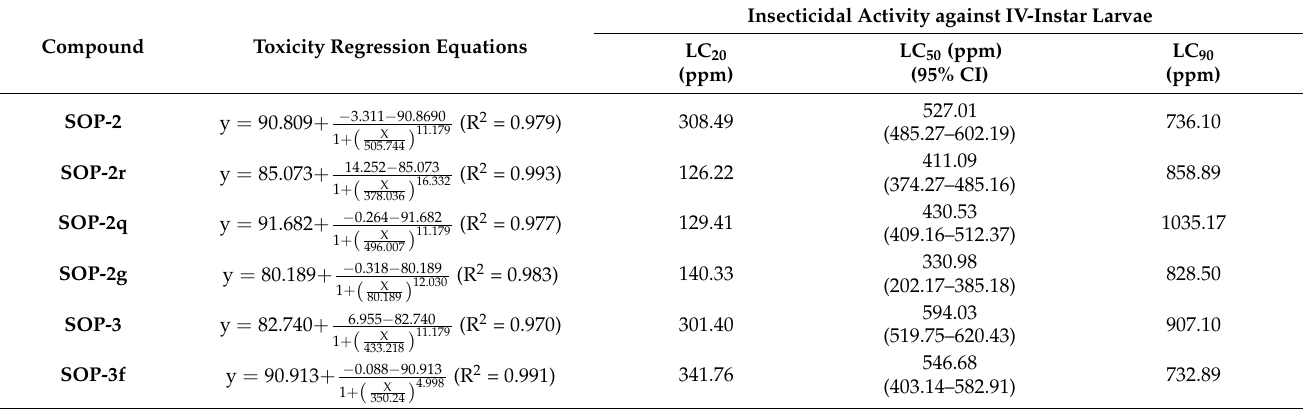
Figure 1. The dose–response curves on larvae of Ae. albopictus : ( A ) SOP-3f ; ( B ) SOP-2r ; ( C ) SOP-2 ; ( D ) SOP-2g ; ( E ) SOP-3 ; ( F ) SOP-2q . The pink dot means the mortality at each concentration. The error bars shown mean the experiment was repeated three times independently and standard deviations were reasonable. Table 3. The LC 20 , LC 50 , and LC 90 values of six compounds on Ae. albopictus larvae.